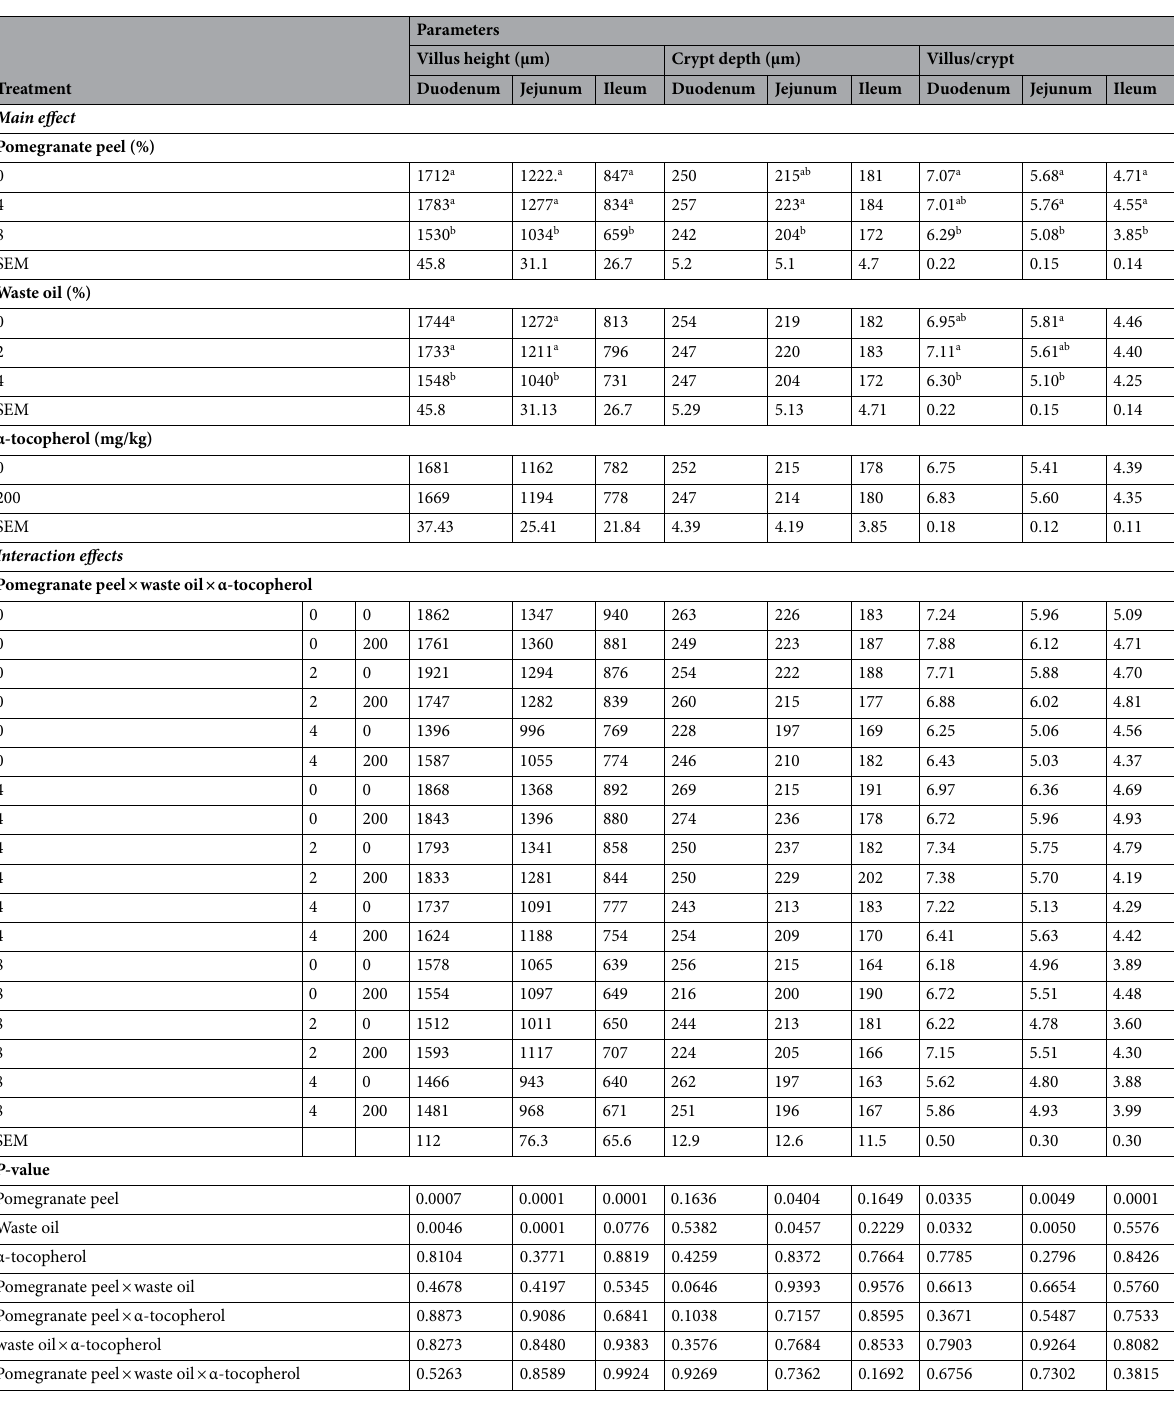
Table 9. The effects of using pomegranate peel powder, waste vegetable oil and α-tocopherol in diets on gut morphology (30, 60 and 90% of gut) in broiler chickens. SEM standard error of means, P -value probability values. a,b ,c Means in columns with the same superscript do not differ significantly P <